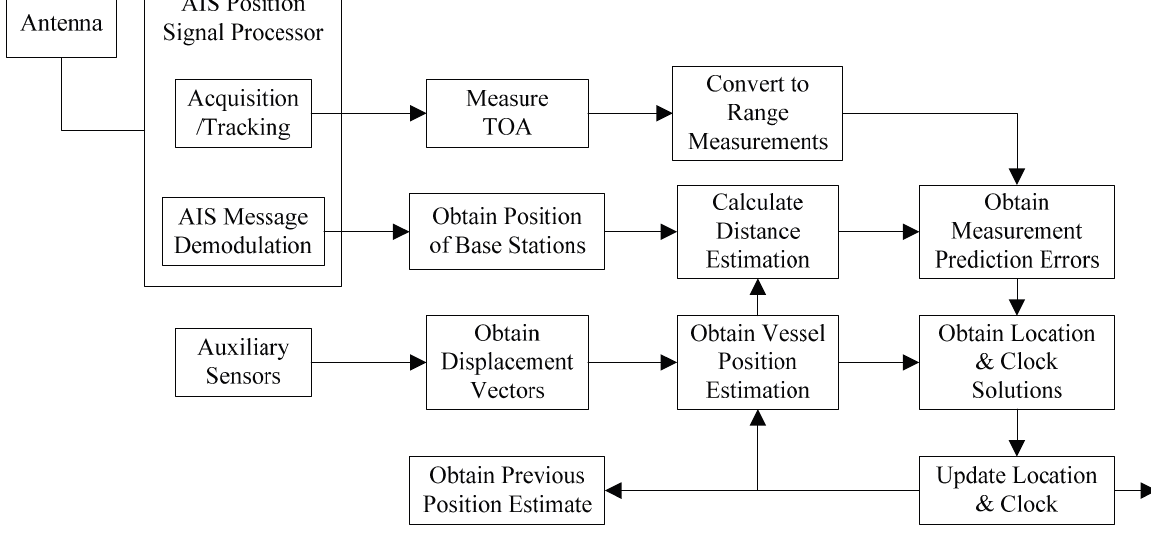
Figure 2. Implementation scheme of position estimation based on displacement